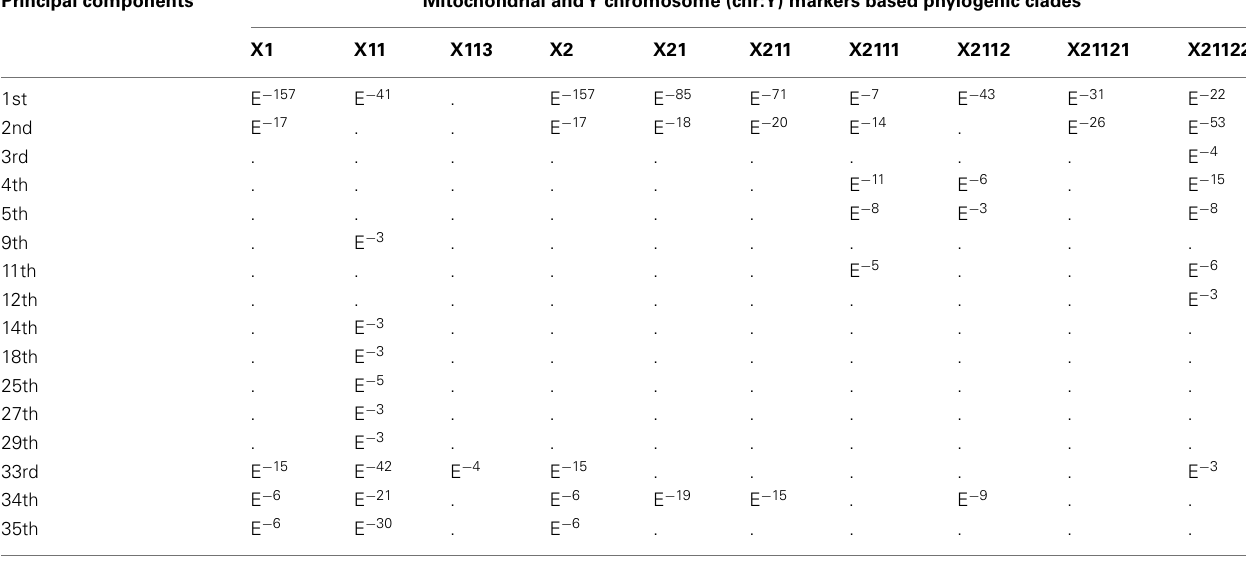
Table 1 | Principal Components based on autosomal markers and associated phylogenic clades of mitochondrial DNA (mtDNA) andY chromosome chr:Y